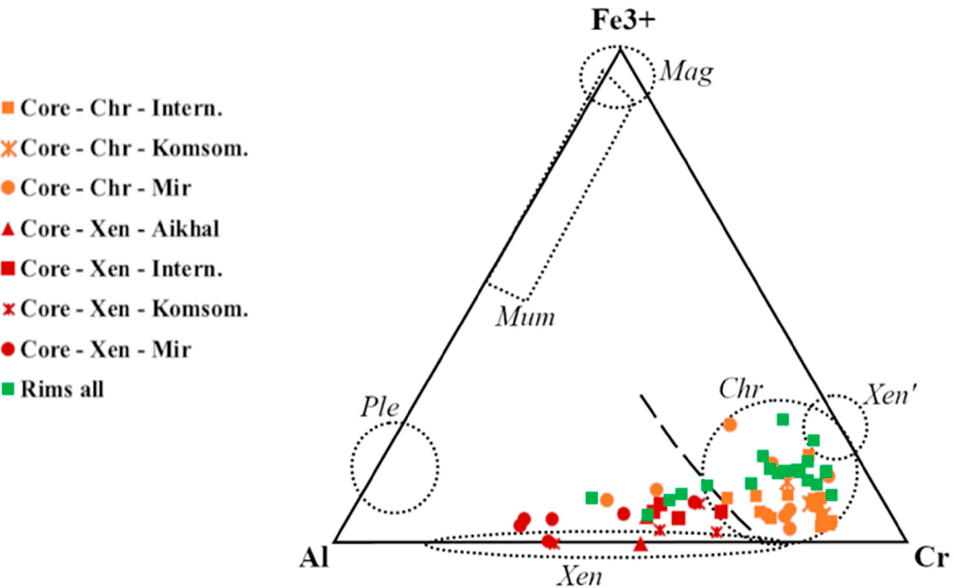
Figure 2. Compositional variations of Cr-spinel grains from this study shown in terms of Al-Fe 3+ -Cr. Compositional fields are after Roeder and Schulze (2008) [30]. The dashed line was calculated in this work, see text.